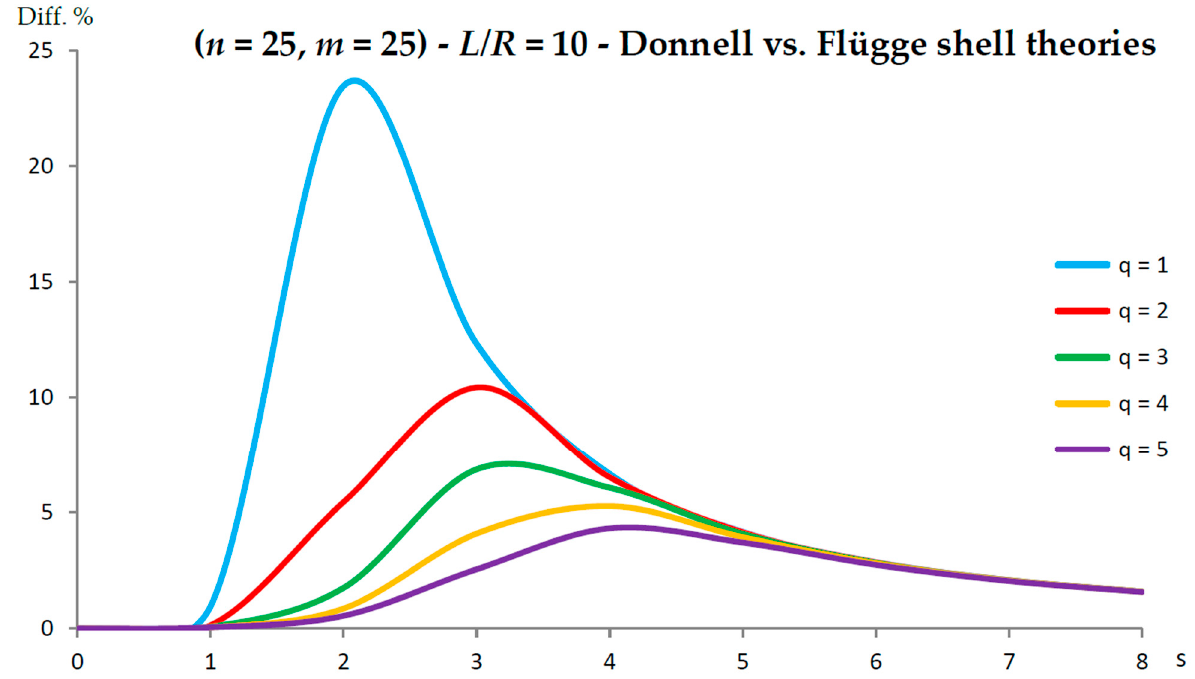
Figure 6. Percentage differences between the radial natural frequencies obtained via Donnell and Flügge shell theories (Flügge as the reference). Anisotropic elastic shell model. Simply supported SWCNT of Table 1 with chirality indices (𝑛 = 25, 𝑚 = 25) and aspect ratio 𝐿/𝑅 = 10 . Number of longitudinal half-waves 𝑞 . Number of circumferential waves 𝑠 .